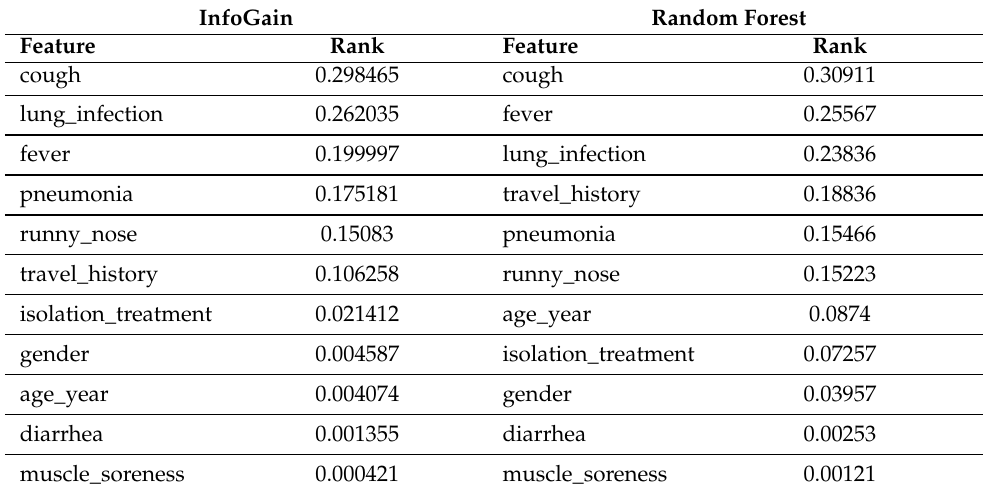
Table 3. Features importance evaluation using Information Gain and Random